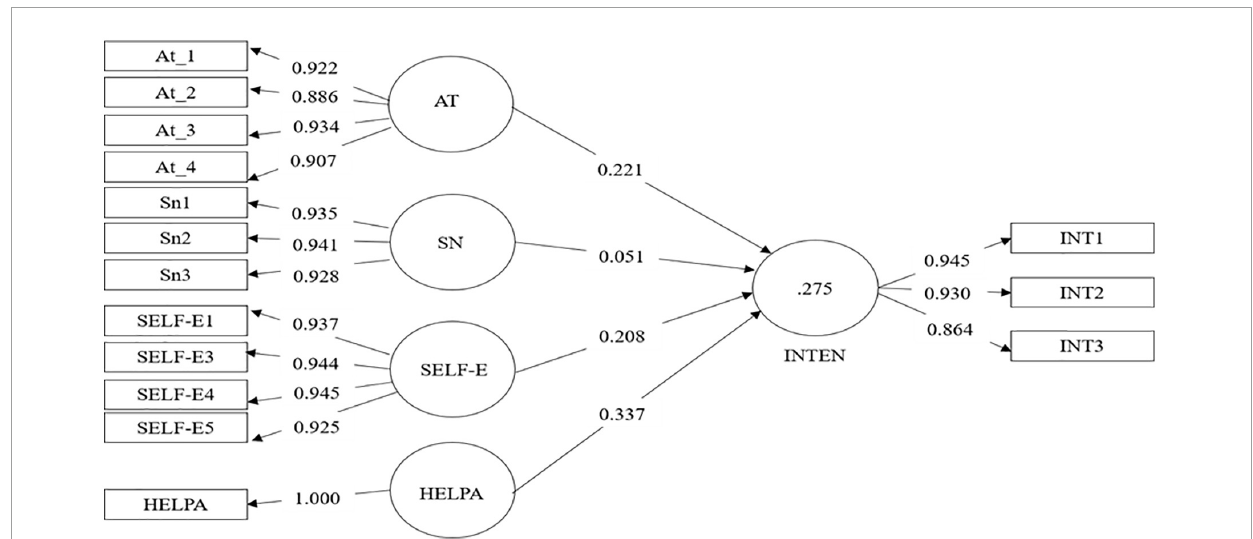
FIGURE2 Path model estimation. At_1 = attitude 1 [(item 1 × item 5)/5], At_2 = attitude 2 [(item 2 × item 6)/5], At_3 = attitude 3 [(item 3 × item 7)/5], At_4 = attitude 4 [(item 4 × item 8)/5]; SN1 = subjective norm 1 [(item 1 × item 4)/5], SN2 = subjective norm 2 [(item 2 × item 5)/5], SN3 = subjective norm 3 [(item 3 × item 6)/5]; AT, attitude; SN, subjective norm; SELF-E, self-efficacy; HELPA, help-seeking in the past; INT, intention.